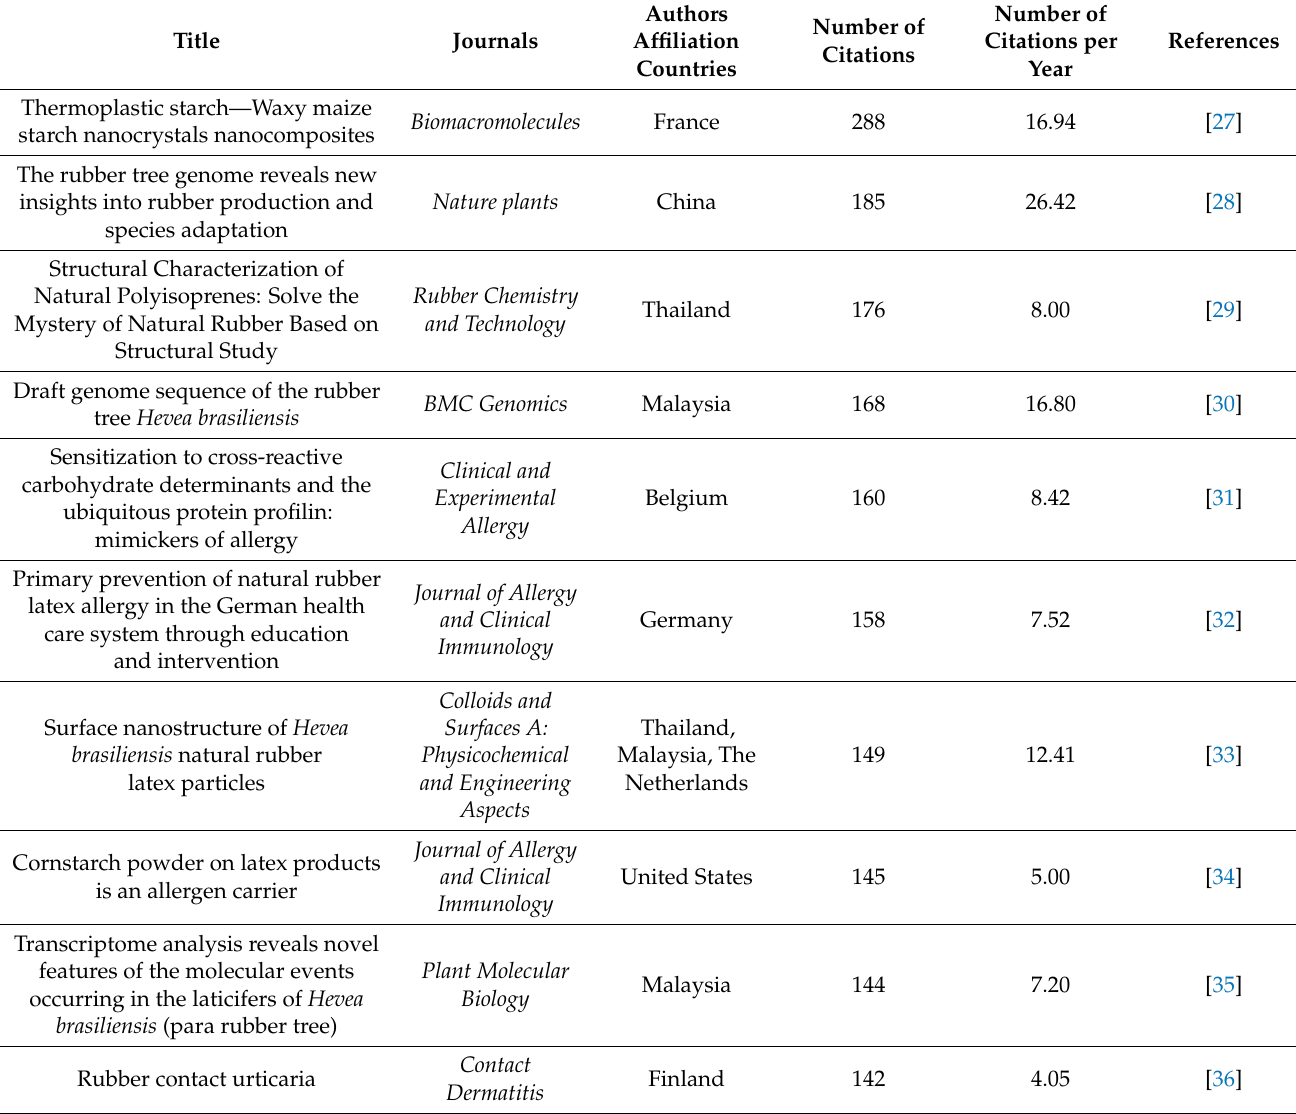
Table 1. Documents with the highest citations in global research on